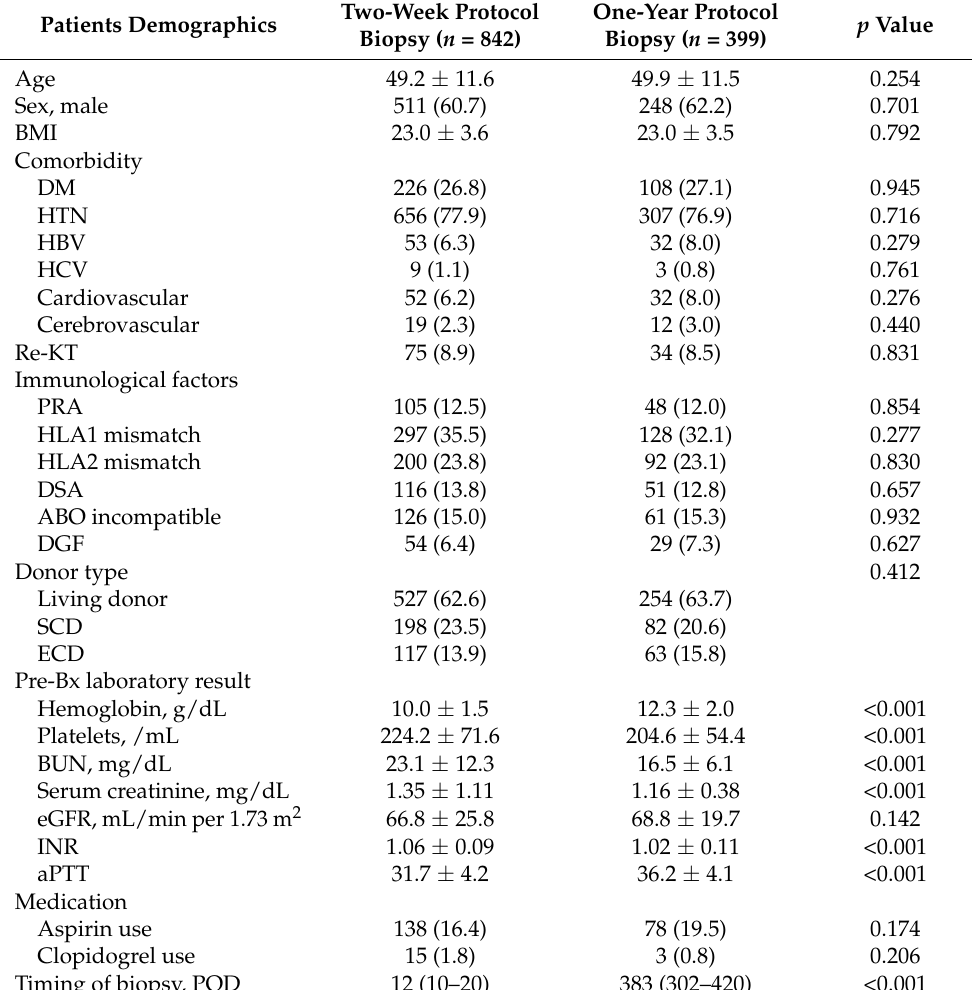
Table 1. Baseline characteristics of two-week and one-year protocol biopsies. Patients